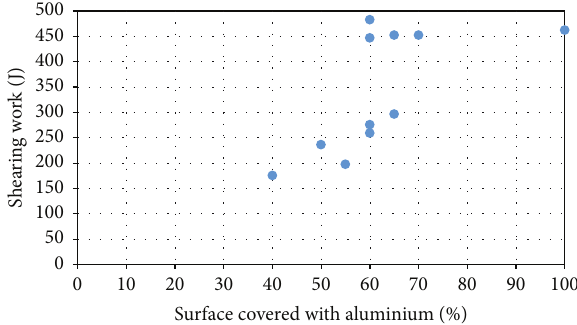
Figure 17: The comparison of shearing work of the friction welded AlMg3 aluminium alloy-austenitic steel joints and the surface area of the aluminium sediment on steel (according to